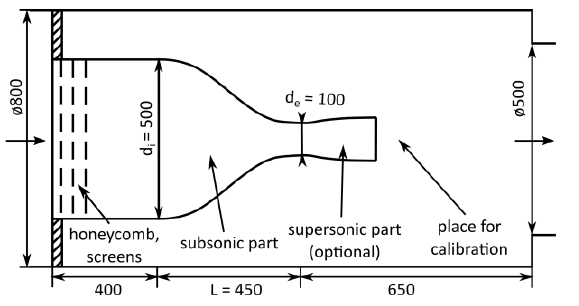
Fig. 1. The sketch of the calibration facility concept.